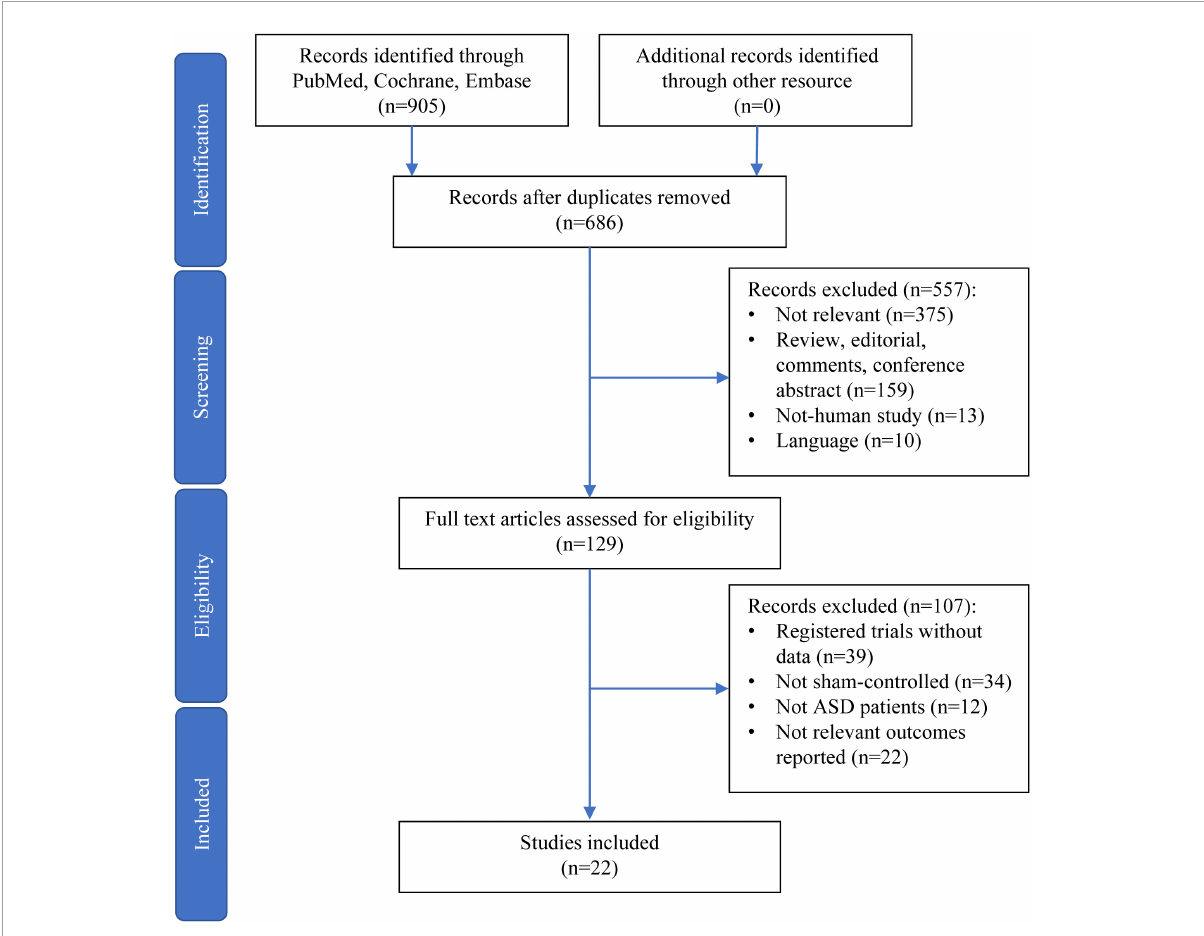
FIGURE1 Preferred Reporting Items for Systematic Reviews and Meta-Analyses diagram for the selection of